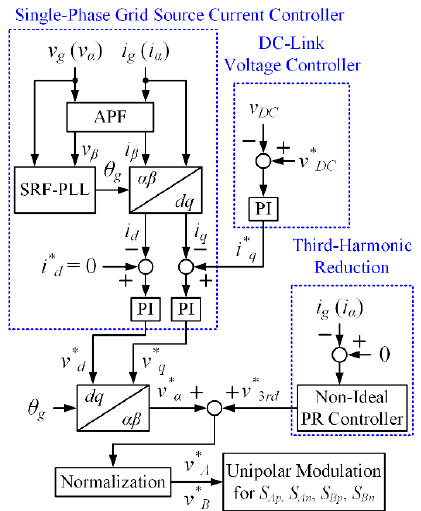
Figure 6. Control block diagram for full-bridge converter of integrated OBC which performs battery charging.